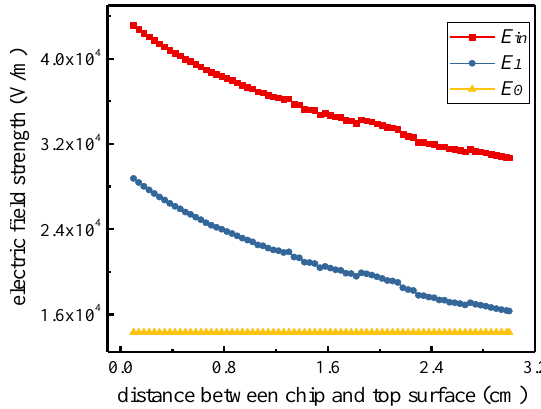
Figure 6. The modulation measurement results of E in , E 0 , and E 1 at different distances between the sensor chip and the top surface.